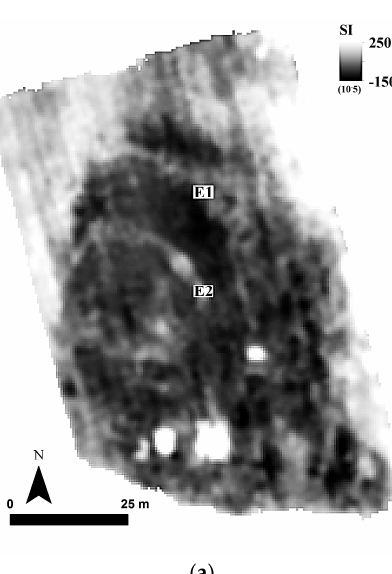
Figure 21. Magnetic susceptibility ( a ); and electromagnetic conductivity ( b ) results from Perivlepto/Kastraki 2.